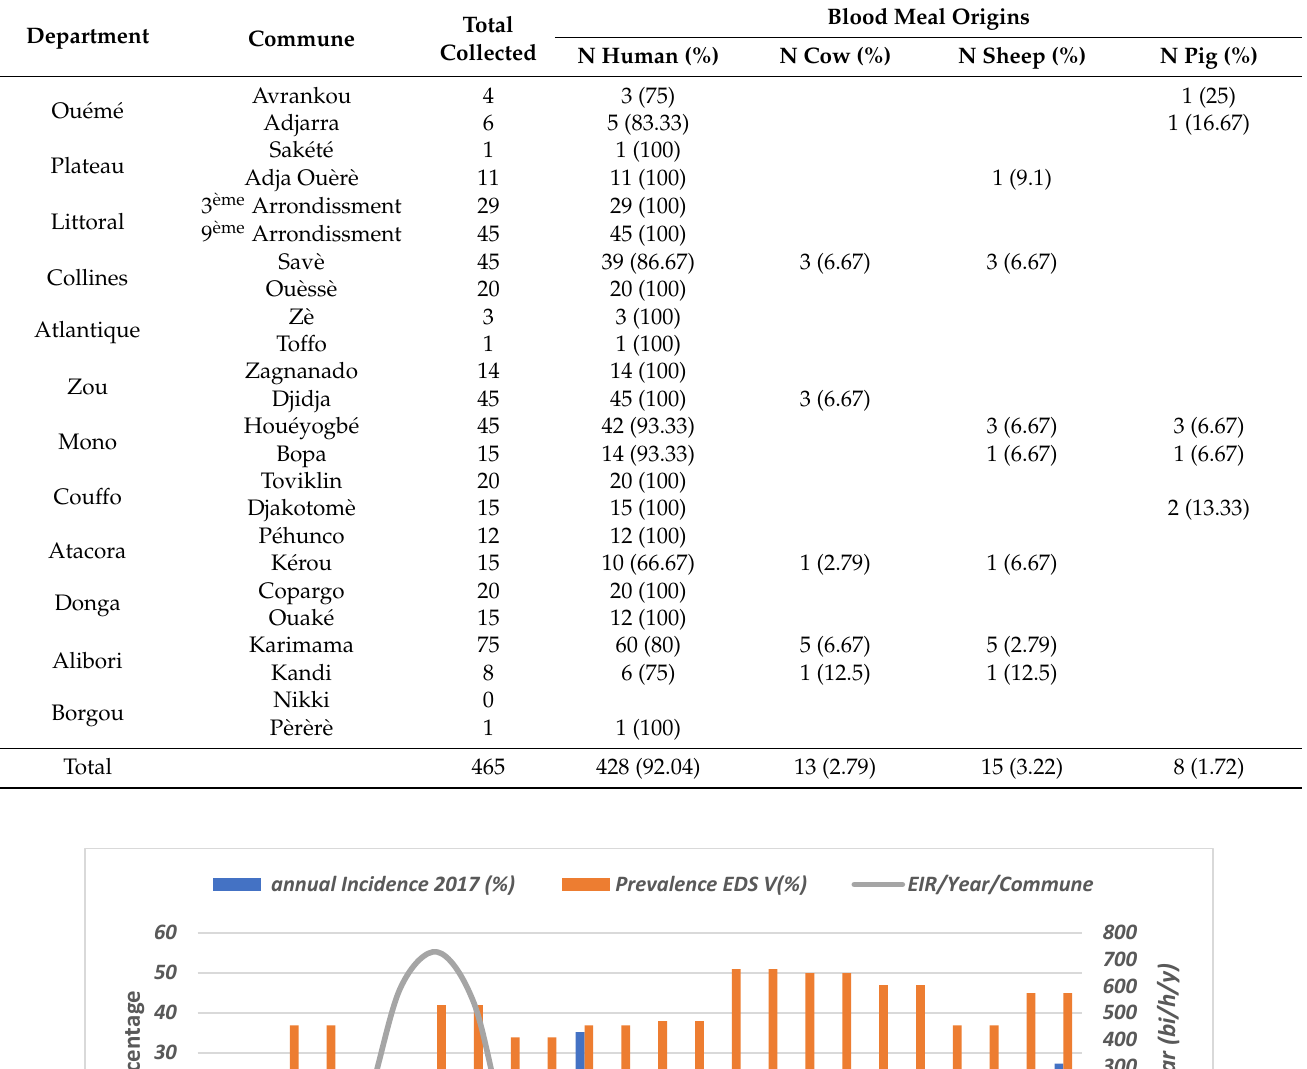
Table 4. Origins of blood meals of An. gambiae s.l. females collected in the departments of Benin.